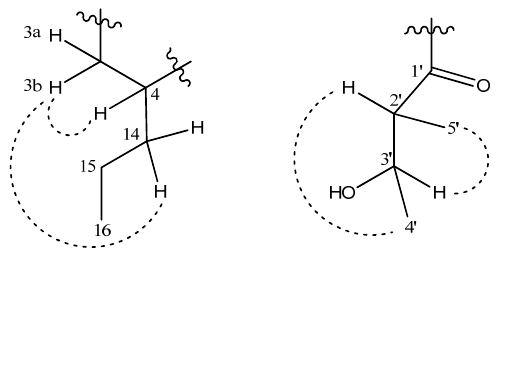
Figure 2. NOESY correlations between 1 H and 1 H in 1